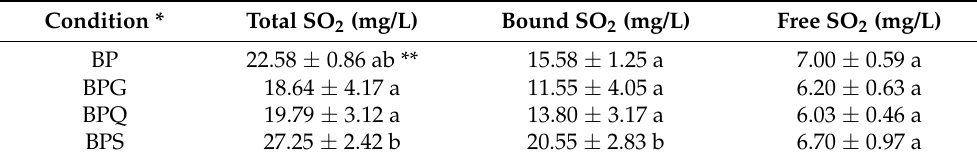
Table 2. SO 2 composition of wines after ageing.